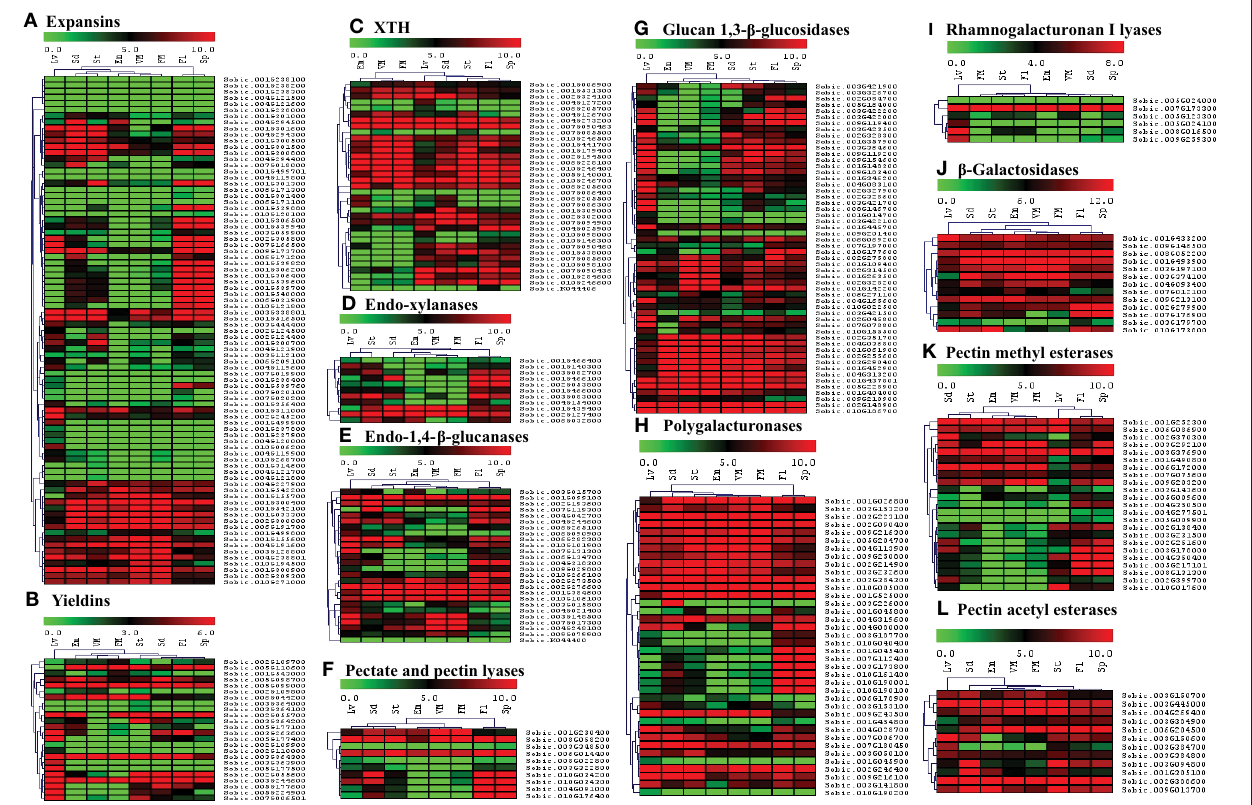
FIGURE 7 | Heat map showing hierarchical clustering of the sorghum’s cell wall related gene families involved in reassembly and degradation in various developmental stages. (A) Expansins, (B) Yieldins, (C) XTH, (D) Endo-xylanases, (E) Endo-1, 4- β -glucanases, (F) Pectate and pectin lyases, (G) Glucan 1, 3- β -glucosidases, (H) Polygalacturonases, (I) Rhamnogalacturonan I lyases, (J) β -Galactosidases, (K) Pectin methyl esterases, (L) Pectin acetyl esterases. RNA-seq data from various developmental stages viz. stem (St), 20 days old leaves (Lv), vegetative meristem (VM), floral meristem (FM), spikelet (Sp), flowers (FL), embryos (Em), and seeds (Sd) were mapped on gene sequences related to above gene families. The respective RPKM values were used to construct heatmap with scale bar on the top showing expression of the genes. Red colors represent high expression whereas green represents low expression.